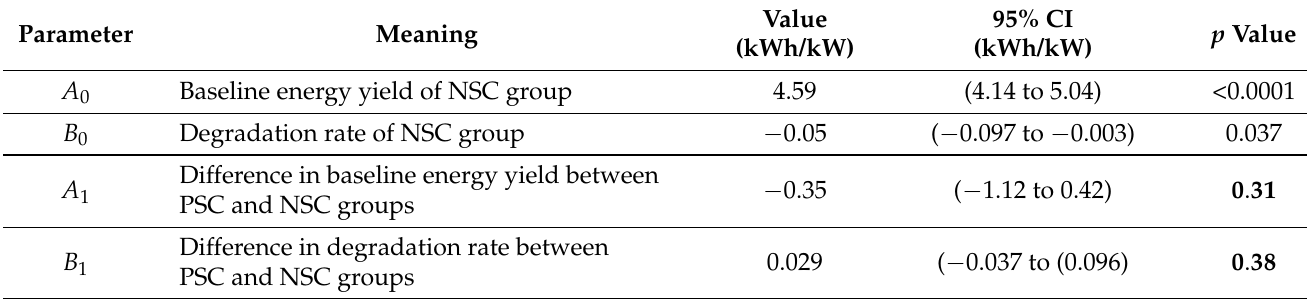
Table 6. The fixed-effects results of the linear decline model based on the MEM in Equation (8). Parameter